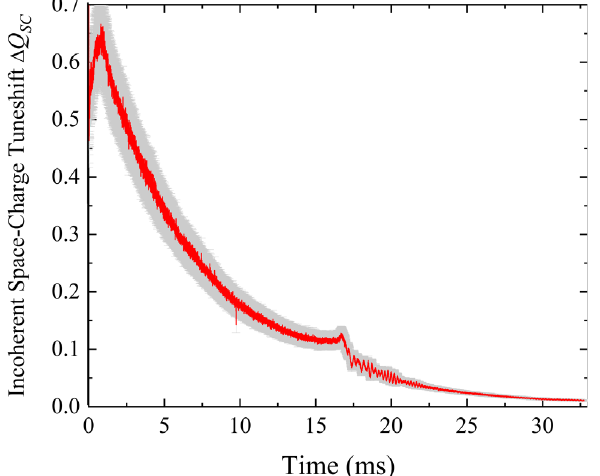
FIG. 15. Calculated vertical space-charge tuneshift parameter for the Booster cycle with N p ¼ 4 . 6 × 10 12 . (The shaded area indicates 10% uncertainty, mostly due to the IPM emittance